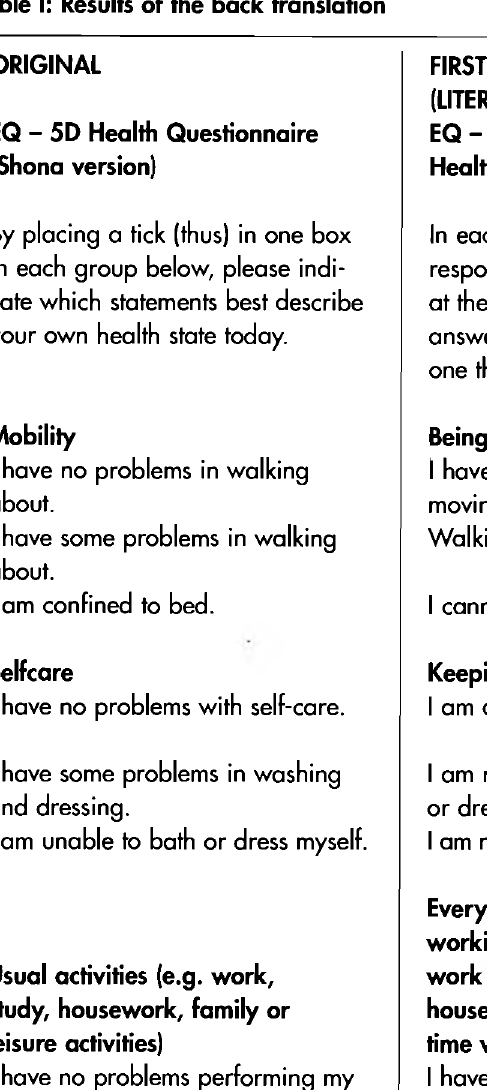
Table I: Results of the back translation ORIGINAL EQ - 5D Health